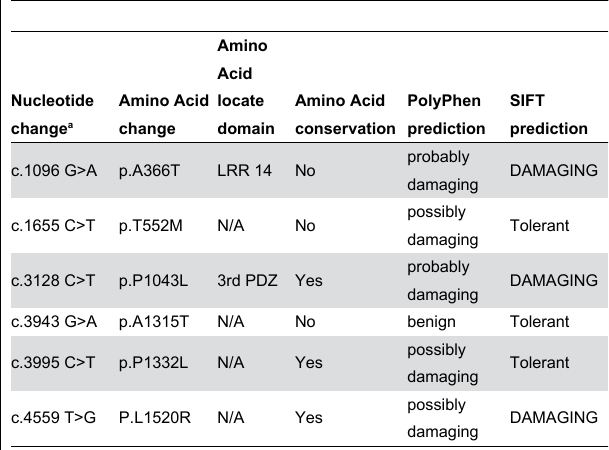
Table 1. Novel Rare Variants detected in NTDs in the CDS of SCRIB Gene in Spina